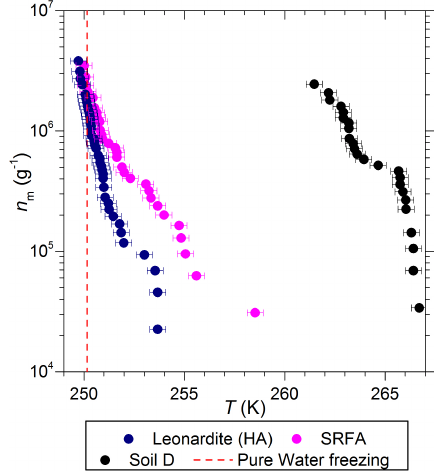
Fig. 7. Ice active site densities per unit mass ( n m ) determined for 0.1wt% suspensions of two proxies for humic-like substances (HULIS): leonardite humic acid (HA) and Suwanhee River fulvic acid (SRFA). Also shown are n m values for a 0.1wt% suspension of soil D for comparison. The dashed red line indicates the lower temperature limit for these experiments, above which point less than 10% of 1µL Milli-Q purified water droplets were observed to freeze across six repeat